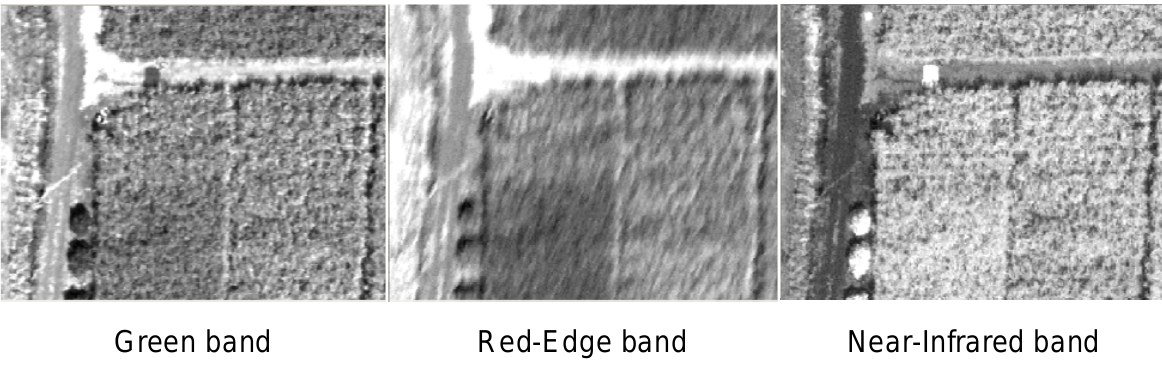
Figure 5. Subset of spectral images acquired with the three cameras (June 29).